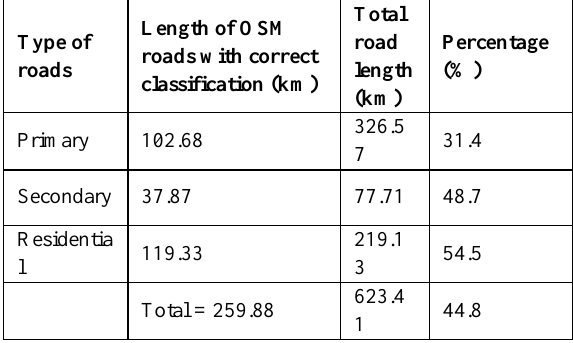
Table 9: The percentage of correctly classified roads according to the type of road